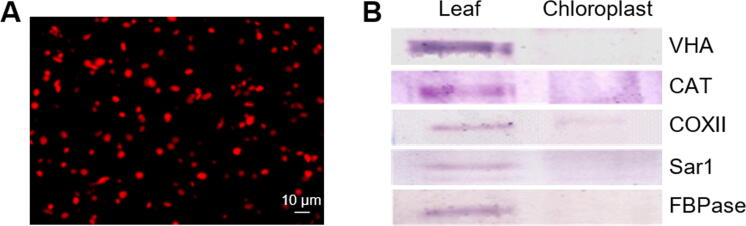
Integrity and purity determination of chloroplasts isolated from alkaligrass leaves A. Autofluorescence of the purified chloroplasts were visualized under a fluorescence microscope, Bar = 10 μm. B. Western blot analysis of proteins from purified chloroplasts. Proteins from the leaves and purified chloroplasts were separated on 12.5% SDS-PAGE, and immunodetected with rabbit polyclonal antibodies against VHA (vacuolar-type H+-ATPase, vacuole marker), CAT (catalase, peroxisome marker), COXII (mitochondrial cytochrome oxidase subunit II, mitochondrial marker), Sar1 (secretion-associated and ras-related protein 1, endoplasmic reticulum marker), and FBPase (cytosolic fructose 1,6-biphosphatase, cytosolic marker), respectively.